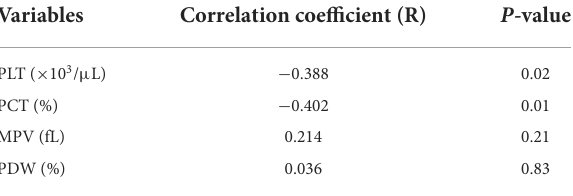
TABLE 1 Correlation between relative prostatic size and platelet indices.